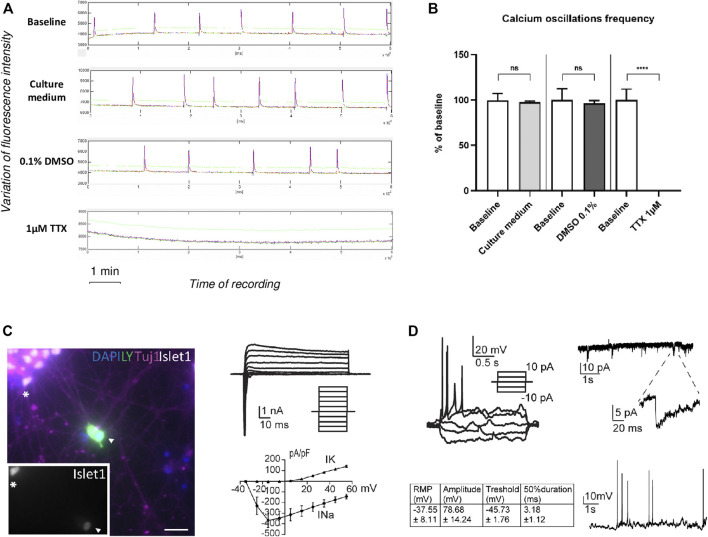
Functional characterization of Motor neurons. (A) Representatives traces of Ca2+ oscillations obtained by whole-well recording followed by FDSS. Waveformanalysis of Cal520 dye loaded 28 days old-iCell MN cultures. Cells were stained with Cal520 the day of the recording. Ca2+ oscillations were recorded before (i.e. baseline condition) and after addition of culture medium, 0.1% DMSO or 1 μM TTX. (B) Ca2+ oscillations frequency of iCell Motor Neurons after addition of culture medium, 0.1% DMSO or 1 μM TTX, compared to baseline condition without treatment. Data are represented as mean ± SEM. ANOVA with Sidak correction (****p < 0.0001, n.s. not significant). (C) Left: Patch-clamped iPSC-derived MN (arrowhead) filled with lucifer yellow (LY) and identified after recording by labelling for Islet1 (inset) and Tuj1. Scale bar 20 μm. Right: Voltage-clamp whole-cell current-voltage relationship. Top: representative trace and corresponding voltage steps; bottom: current densities plotted against voltage pulses. (D) Left, Top: Current-clamp whole-cell current-voltage relationship with current pulses applied. Bottom: table summarizing action potentials properties and resting membrane potential (RMP). Right: Synaptic inputs and zoom in on one event. Bottom: spontaneous firing of action potentials.